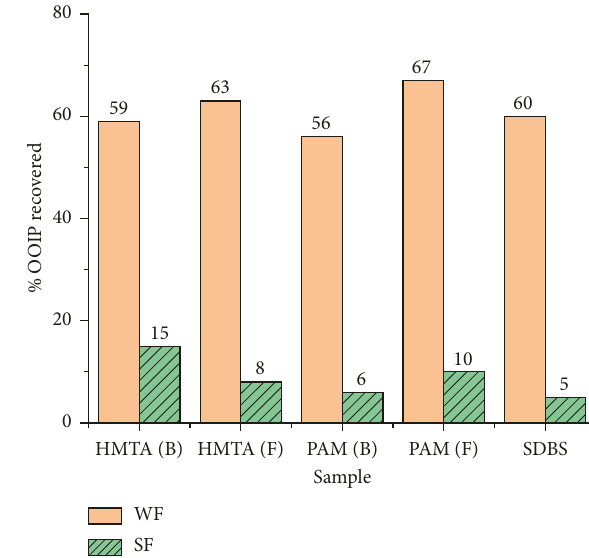
Figure 5: Oil recoveries from imbibition and surfactant flooding.